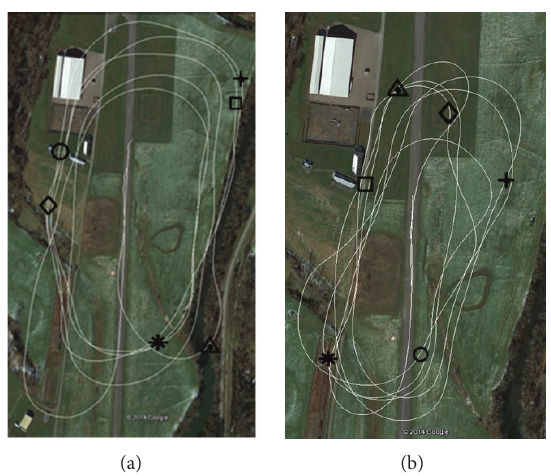
Figure 3: Flighttrajectories forFlight#1 (a)and Flight#2 (b),©2014